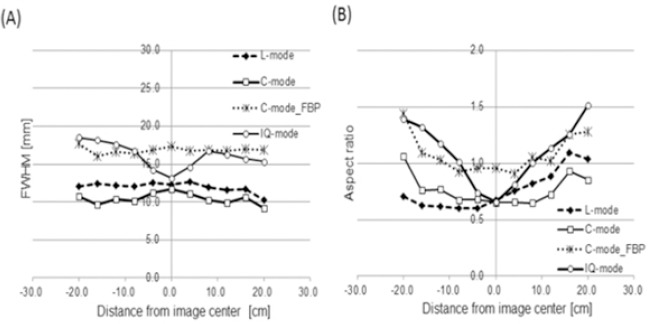
Estimated FWHM and ASR at each location of line sources using acquisition C-, L-, and IQ-modes.(A) Estimated FWHM in radial position. We added FWHM of the filtered back projection (FBP) reconstructed data (C-mode_FBP). Value of FWHM at C-mode_FBP did not depend on location and was reasonably uniform.(B) Estimated ASR tended to increase away from center. C-mode_FBP: C-mode acquisition with FBP reconstruction. ASR=tangential (FWHM) / radial (FWHM)